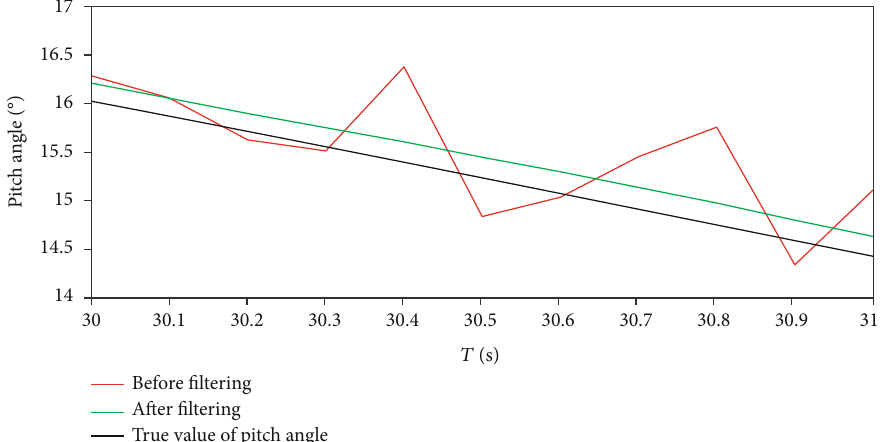
Figure 5: Yaw angle curve before and after fi ltering.